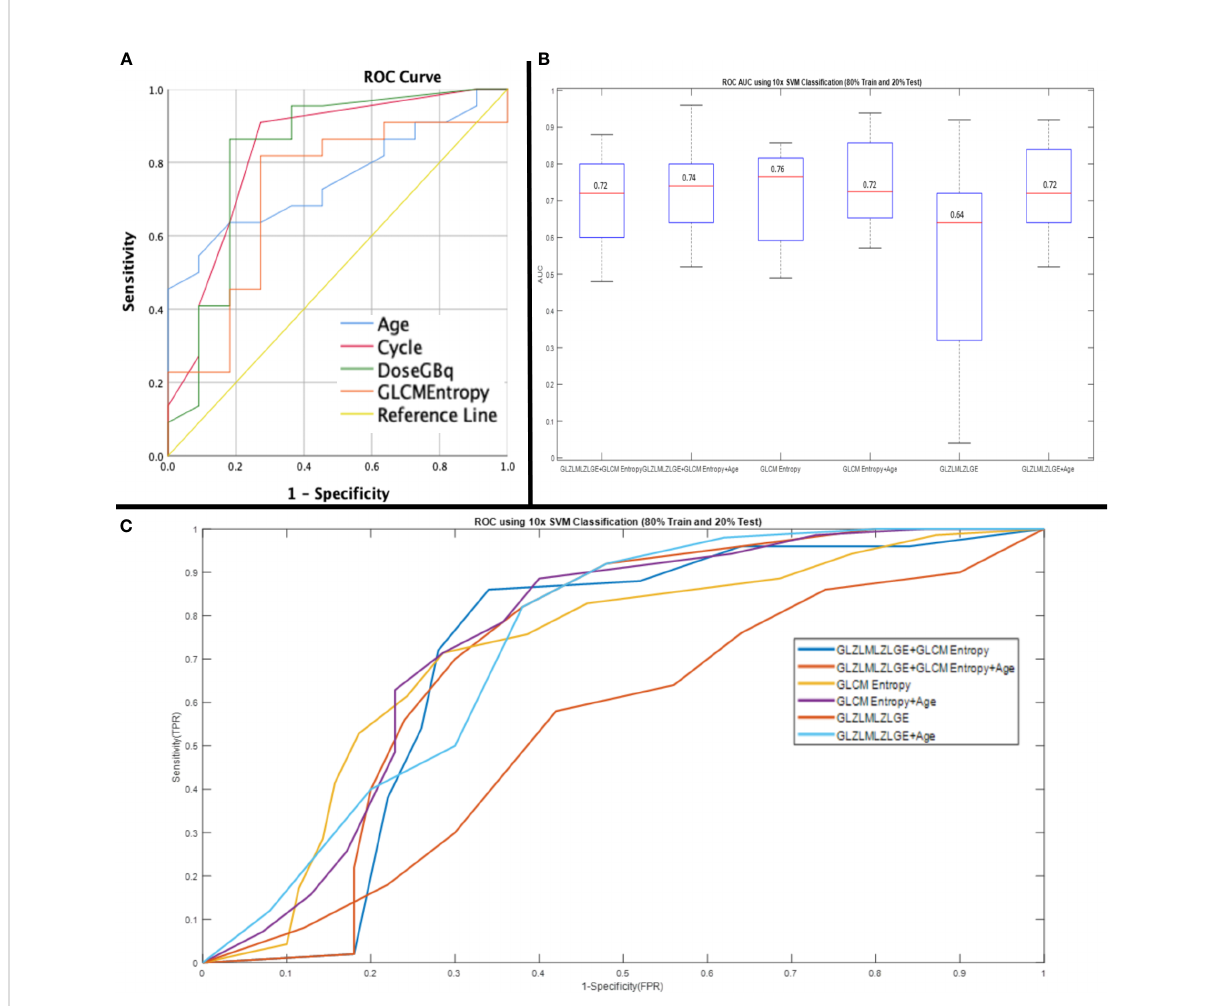
FIGURE 2 Receiver operating characteristic (ROC) curve of parameters showed signi fi cant impact on PSA response (age: AUC, 0.75; 95%CI, 0.59-0.92), (cycle: AUC,0.83; 95%CI, 0.67-0.99), (Dose: AUC, 0.82; 95%CI, 0.65-1), (GLCM entropy AUC, 0.72; 95%CI, 0.52-0.91) (A) and, ROC curve analysis using 10* support vector machine (SVM) classi fi cation (80% train and 20% test) for prediction of response to 177Lu-PSMA therapy (GLZLMLZLGE +GLCM Entropy: AUC, 0.72; 95%CI, 0.63-0.83), (GLZLMLZLGE+GLCM Entropy+Age: AUC, 0.74; 95%CI, 0.67-0.80), (GLCM Entropy: AUC, 0.76; 95%CI, 0.71-0.87), (GLCM Entropy+Age: AUC, 0.72; 95%CI, 0.70-0.86), (GLZLMLZLGE: AUC, 0.64; 95%CI, 0.20-0.62), (GLZLMLZLGE+Age: AUC, 0.72; 95%CI, 065-0.82) (B, C)